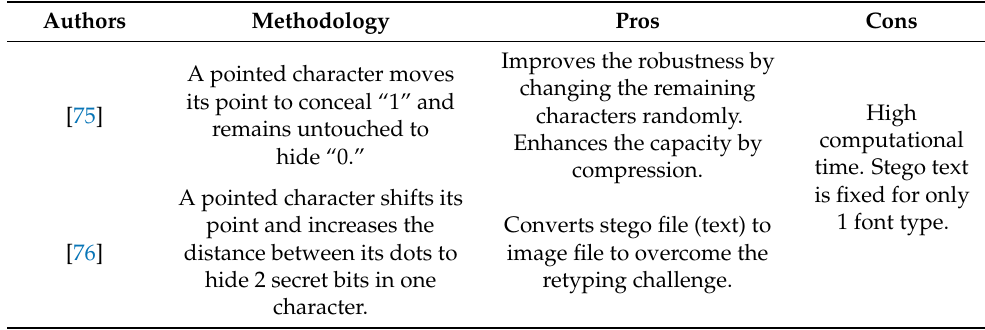
Table 9. A summary of the reviewed articles on the dot